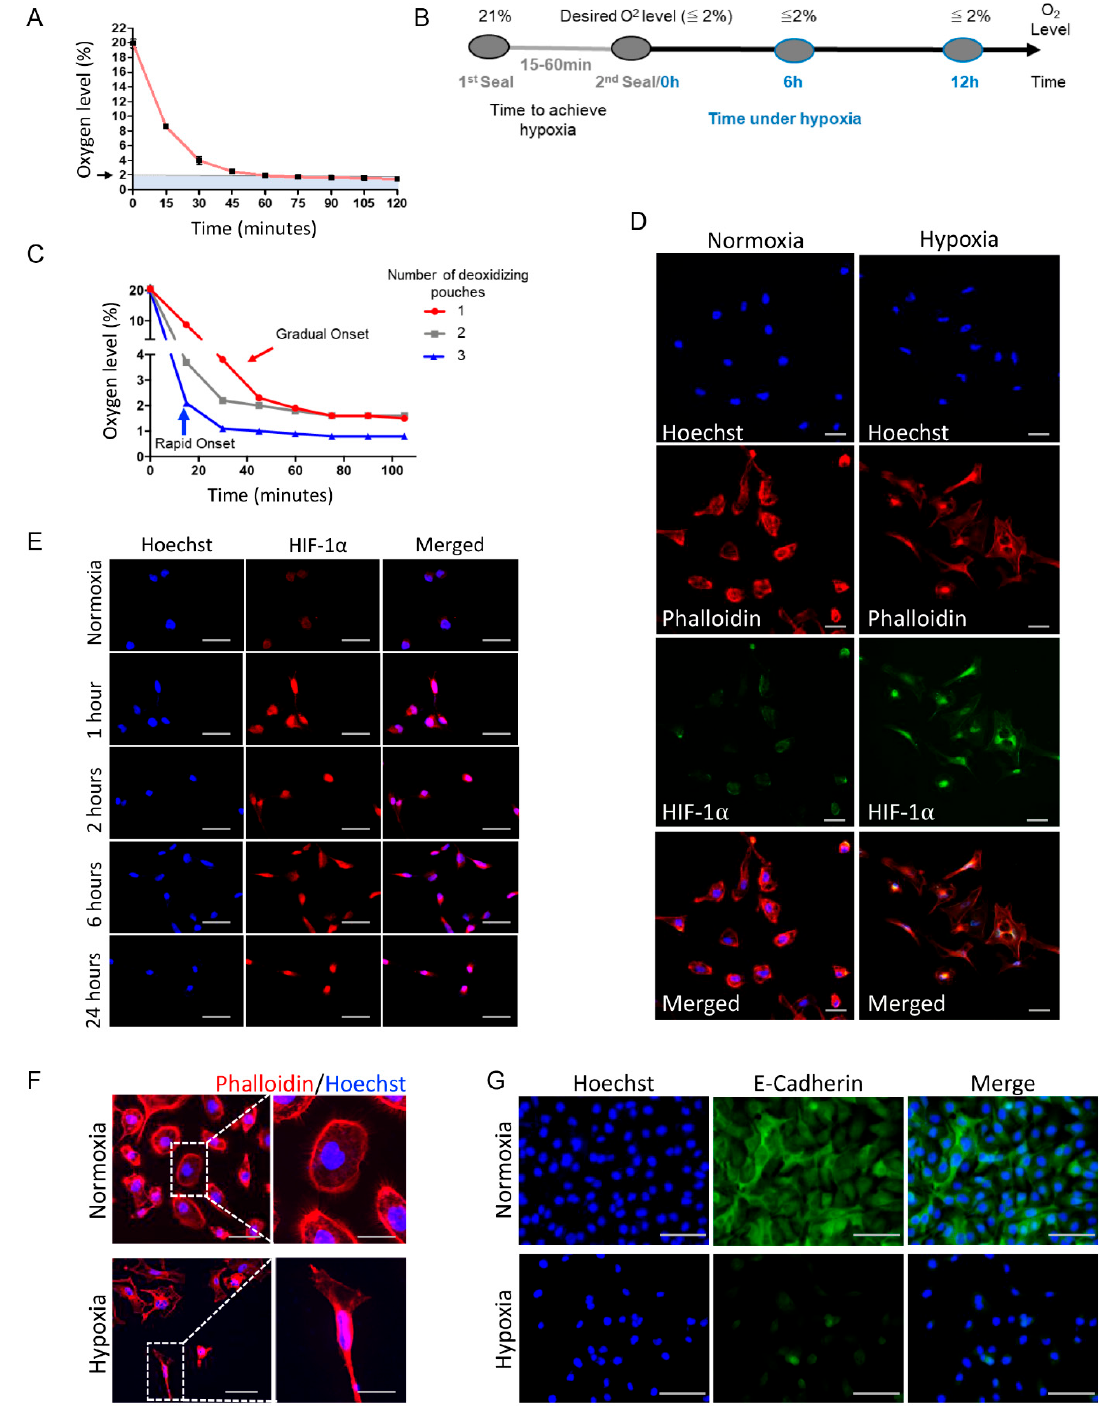
Figure 2. Implementation of deoxidizing absorbers to induce hypoxia and changes in cellular physi- ology. ( A ) The graphic depicts the deoxidizing absorber’s ability to reduce oxygen concentrations leading to hypoxic levels (<2%). ( B ) The diagram illustrates the timeline of the experiments. The time to hypoxia varies from minutes to an hour, depending on the number of oxygen absorbers used. After the desired oxygen concentration is achieved, the chamber receives a second seal that isolates the oxygen absorbers from the hypoxic chamber. Hypoxia or specific low oxygen levels can